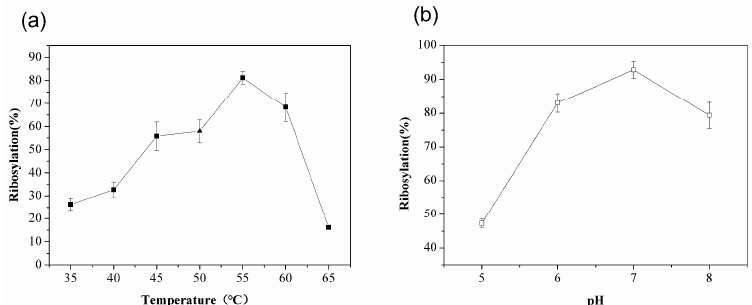
Figure 4. E ff ect of temperature and pH on biosynthesis of 2-amino-6-chloropurine Figure 4. Effect of temperature and pH on biosynthesis of 2-amino-6-chloropurine ribonucleoside